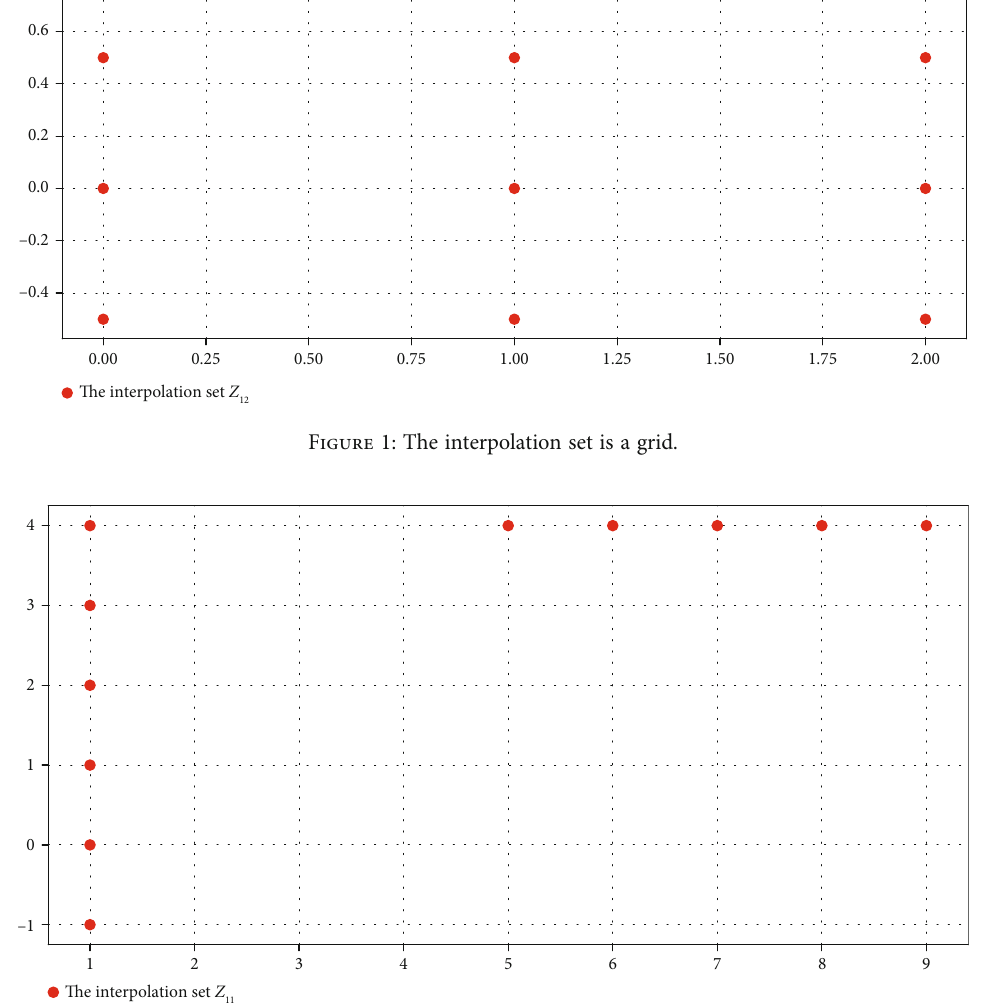
Figure 2: The interpolation set is a random con fi guration.